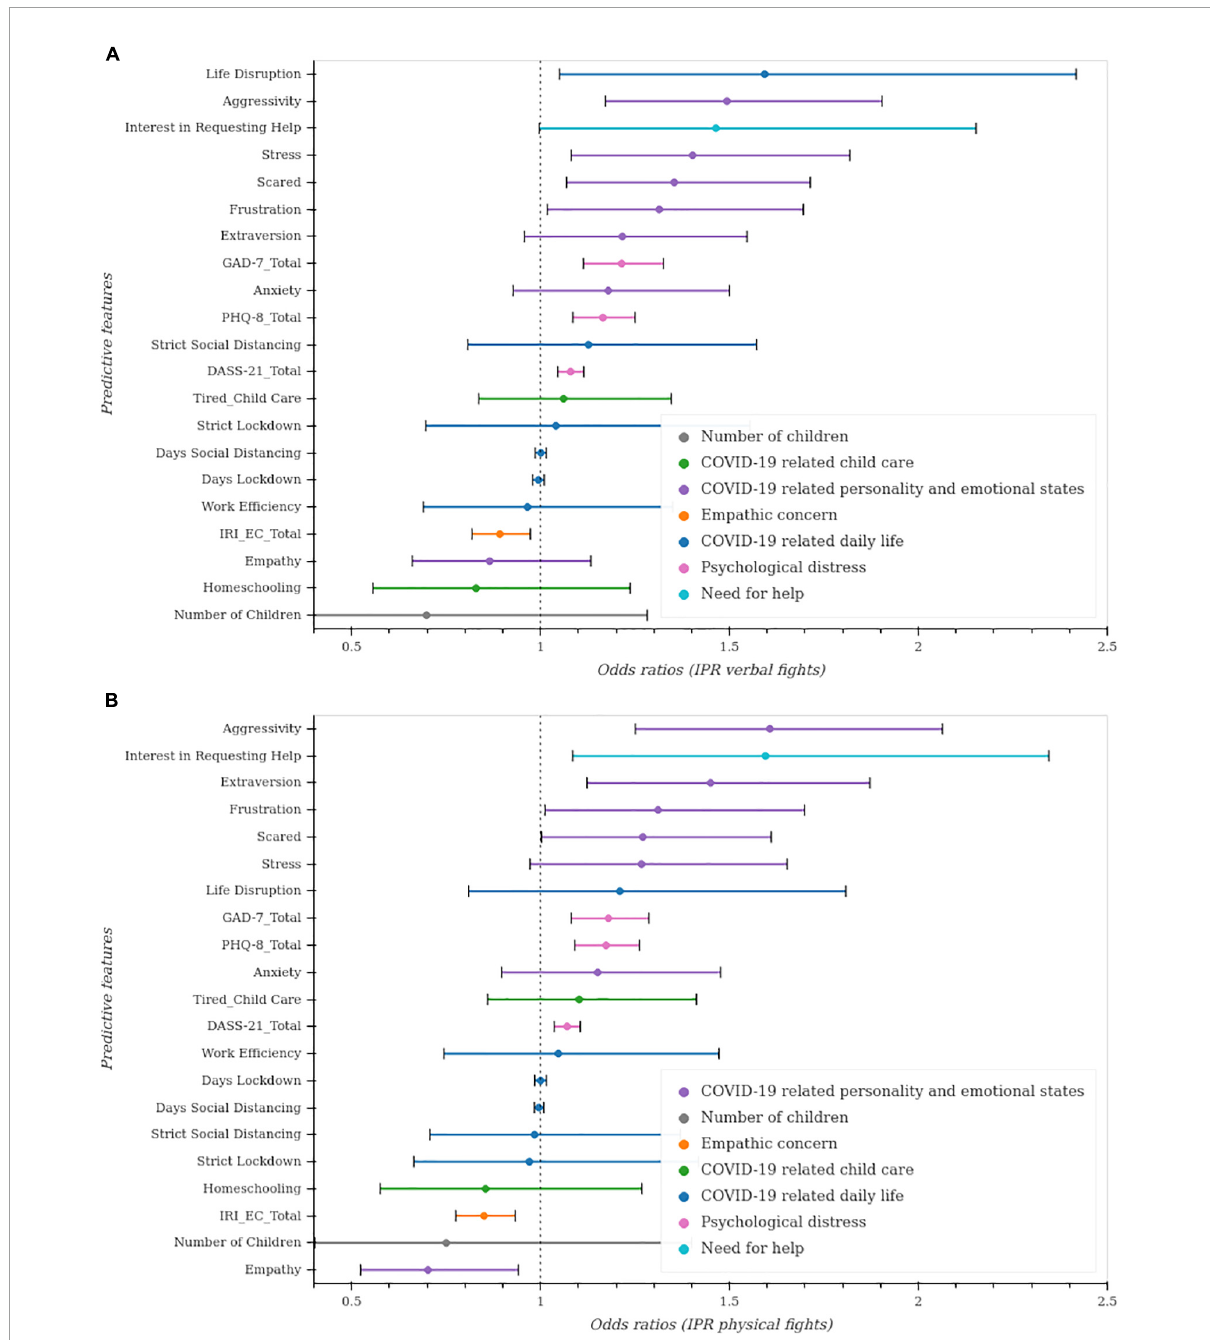
FIGURE5 Unregularized regressions to predict intimate partner violence. Unregularized ordinal regressions were conducted. For each covariate of interest, an ordinal regression model was fit while controlling for age, gender, and state region. The p -values and CI for each model were then adjusted for multiple comparisons using the Bonferroni method. (A) Predictive factors of verbal fights between partners. (B) Predictive factors of physical fights between